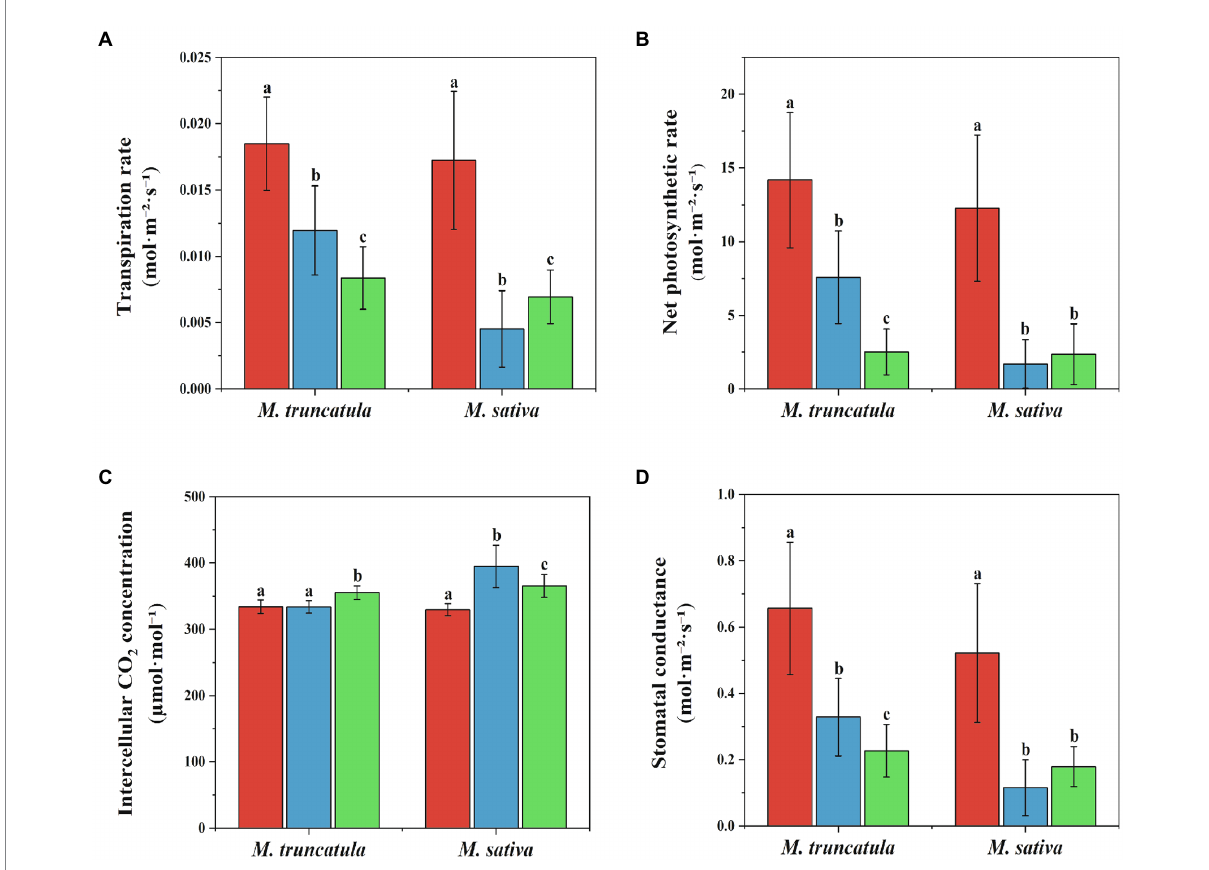
FIGURE 7 Effects of different plant extracts on photosynthesis during the growth of seedlings. (A) Transpiration rate; (B) net photosynthetic rate; (C) intercellular CO 2 concentration; (D) stomatal conductance. Values represent means±SD of seven biological replicates. Different letters above the bars indicate significant difference ( p < 0.05). Control M. truncatula extracts alfalfa